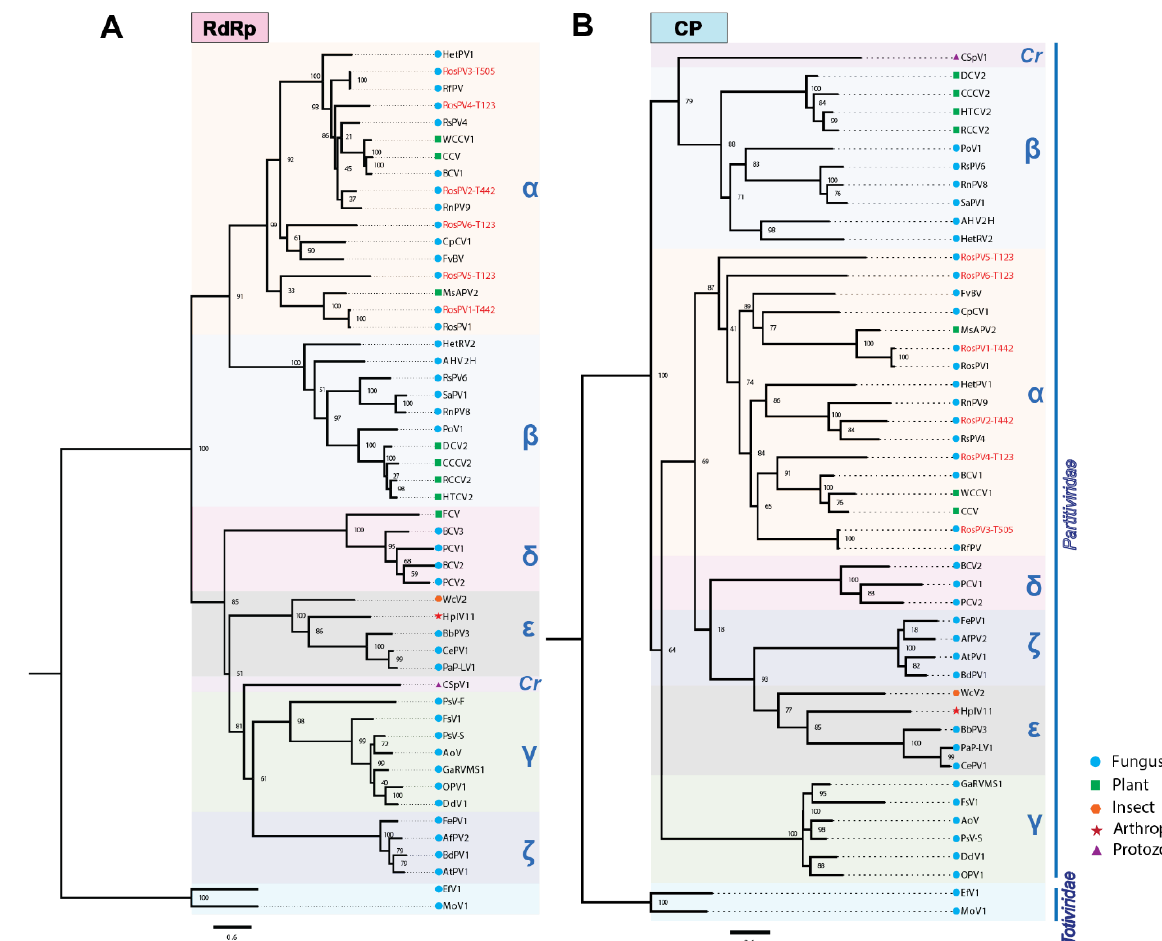
Figure 3. Phylogenetic analyses based on the deduced aa sequences from the six partitiviruses. ( A , B ) Maximum-likelihood trees were constructed based on the alignment of complete aa sequences of RdRp ( A ) and CP ( B ) along with the previously reported members of the genera or proposed genera of the family Partitividae . Two members of the family Totiviridae were used as an outgroup for rooting. Tree construction parameters were chosen based on Smart Model Selection (SMS) function available in PhyML (http://www.atgc-montpellier.fr/sms/, accessed on 3 Nov 2021). Blanch support was obtained with the aLRT-SH-like method and indicated beside each node in percentage (1.00 = 100%). Red texts indicate partitiviruses discovered in this study. The scale bars represent genetic distance. α, Alphapartitivirus ; β, Betapartitivirus ; γ, Gammapartitivirus ; δ, Deltapartitivirus ; Cr , Cryspovirus ; ε, “ Epsilonpartitivirus ” ; and ζ, “ Zetapartitivirus ” . Accession number and the full name of viruses used in this phylogenetic tree constructions can be found in supplementary Table S3.